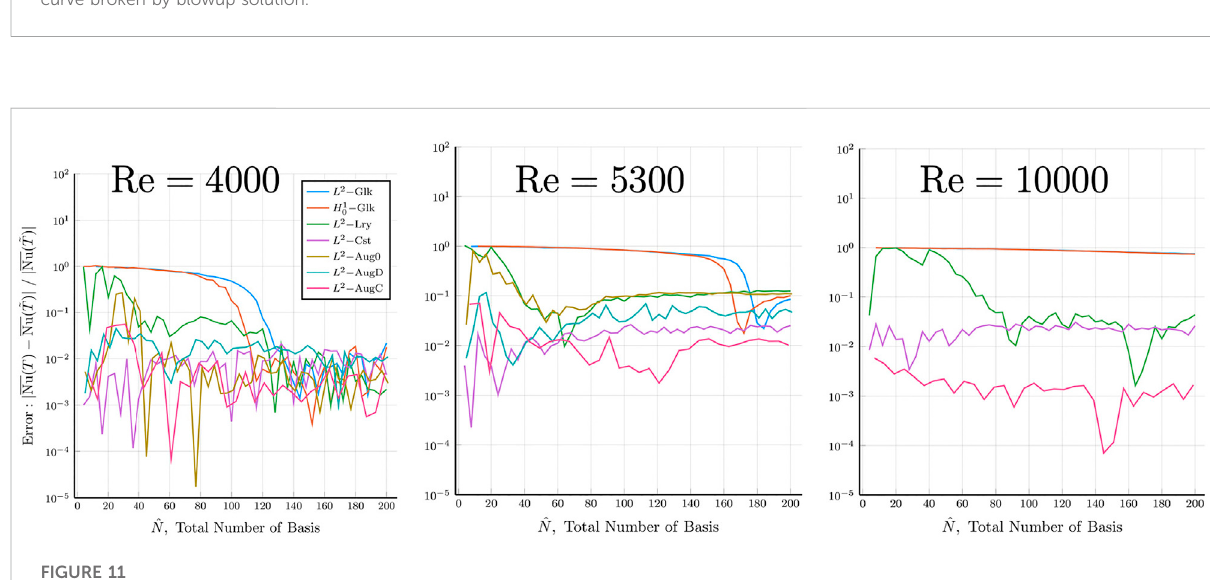
FIGURE 11 Pipe fl ow error in Nusselt number for Re = 4,000, 5300, and